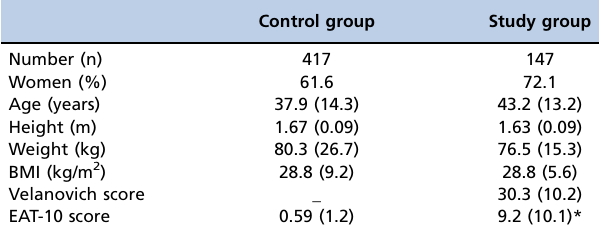
Table 1 - Characteristics of the groups evaluated by the Eating Assessment Tool